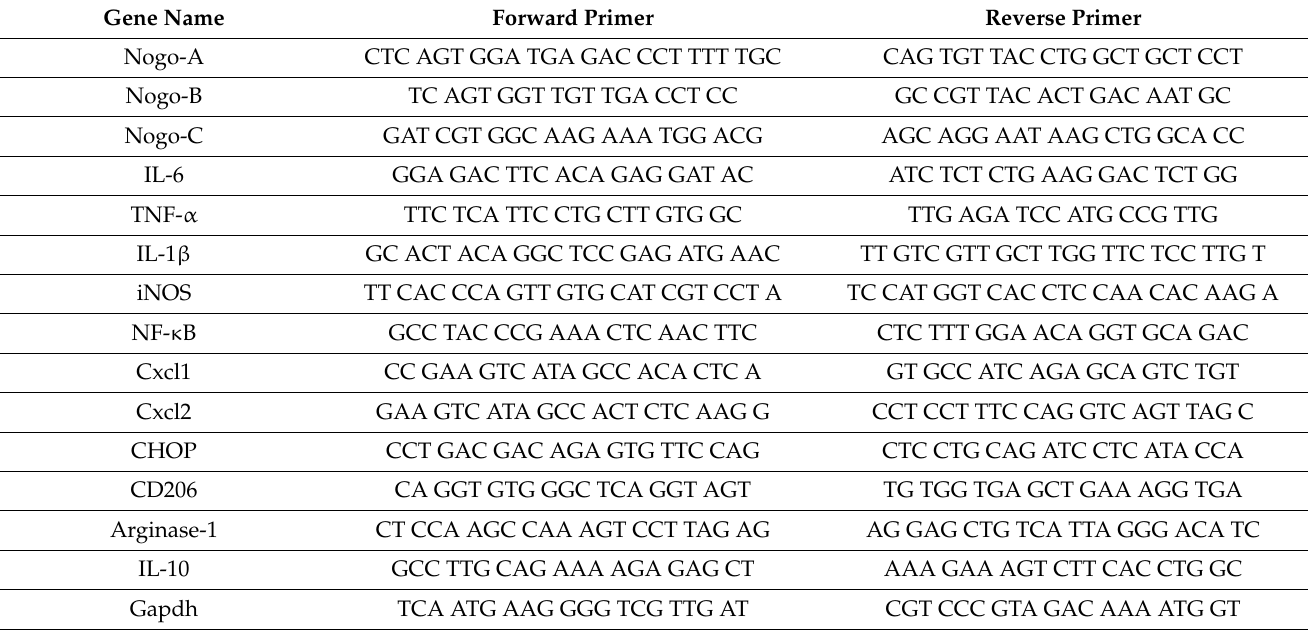
Table 1. Primer sequences used in